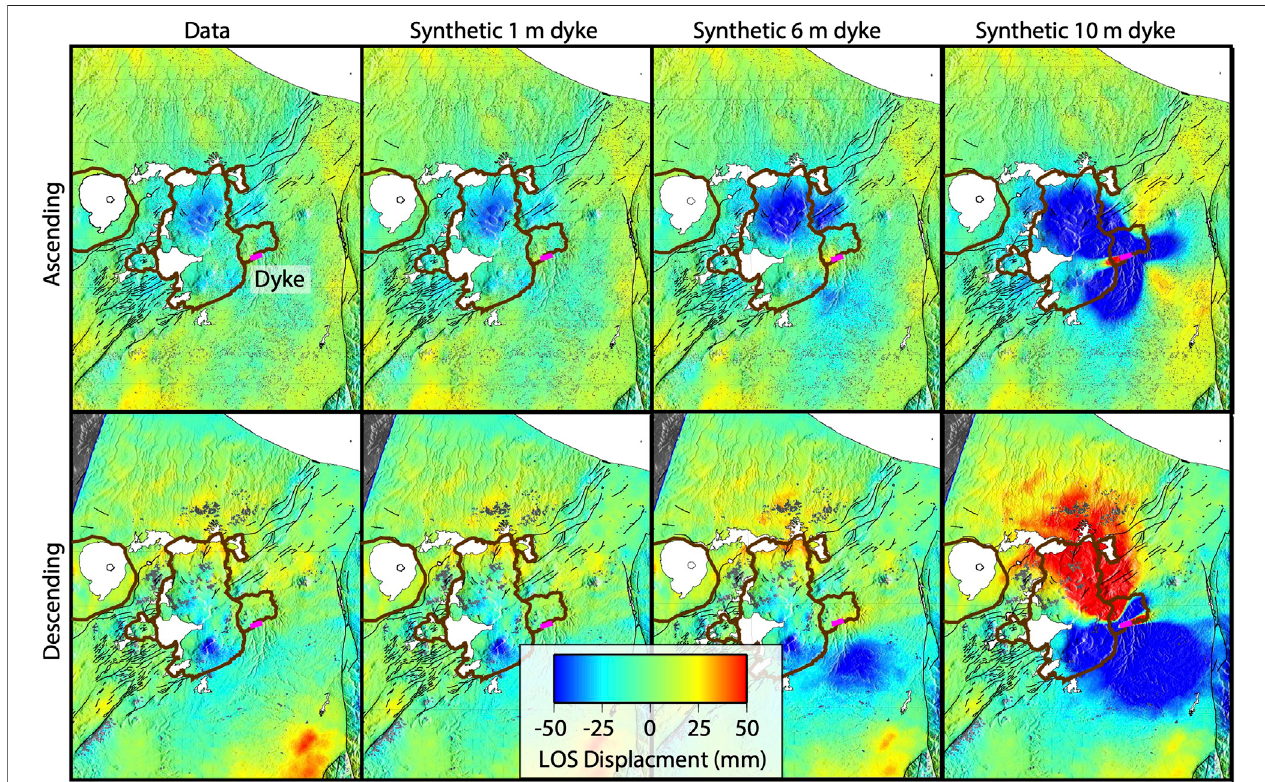
FIGURE6| Lineofsitedisplacementforascending (top) anddescending (bottom) SARdataacquiredbySentinel-1.Thedata (left) showsnoobservableground deformationfromthedykeintrusion.Wethen usesyntheticdykes, centeredonthe2019dykelocationbutwithvaryingthickness,toshowthatonlyadykeintrusion with thickness ≥ 6 m would be